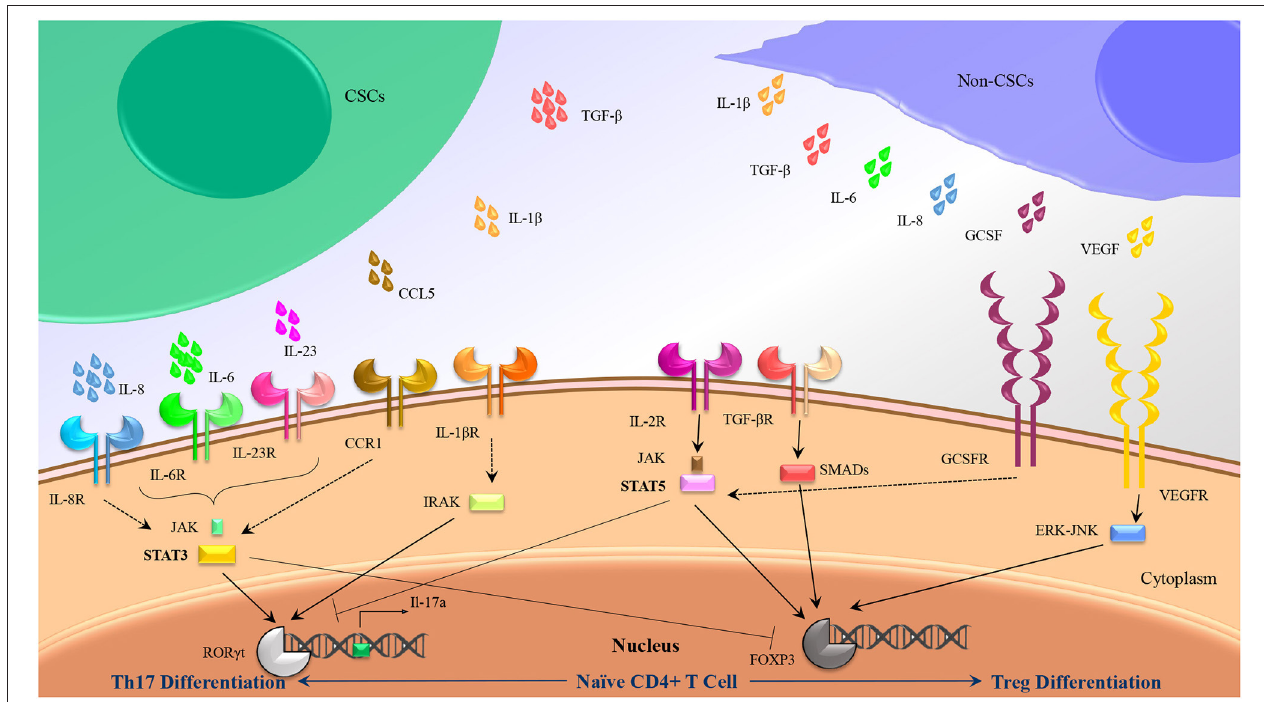
FIGURE 2 | Th17/Treg polarization might be influenced by CSC secretions rather than non-CSC secretions. Besides intrinsic mediators associated to Th17 (IL-1 β , IL-6, and Il-23) and Treg (TGF- β , IL-2) differentiation, some other cytokines produced by CSCs and non-CSCs might induce Th17 and Treg differentiation by crosstalk with the similar internal